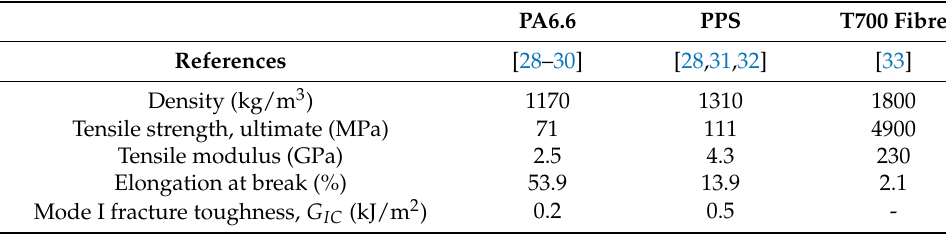
Table 1. Mechanical properties of neat PA6.6, PPS and T700 fibre.